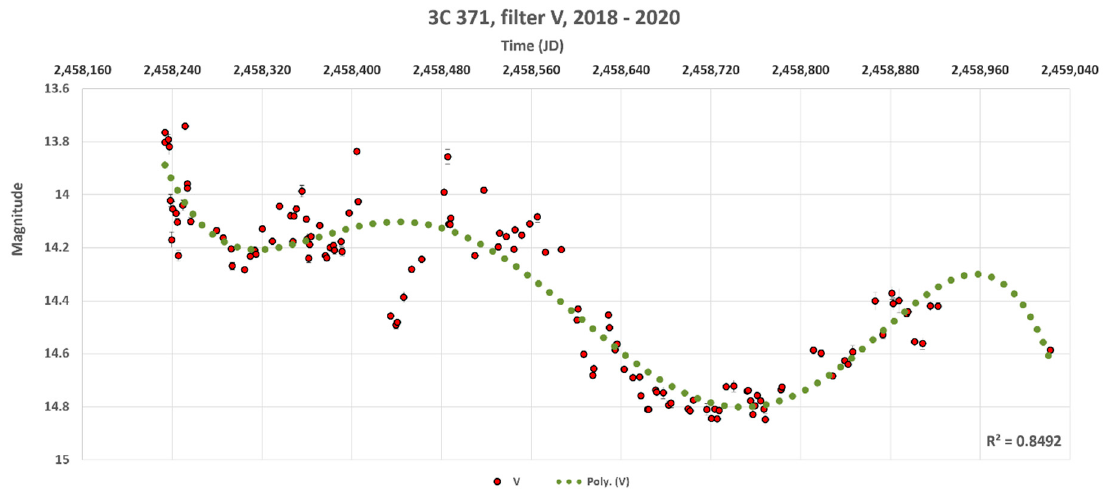
Figure 12. Long-term light curve of 3C 371 in the V-band, obtained in the time interval 2018–2020 (observations from AAVSO database). A wavy long-term trend is visible (polynomial degree is 5).